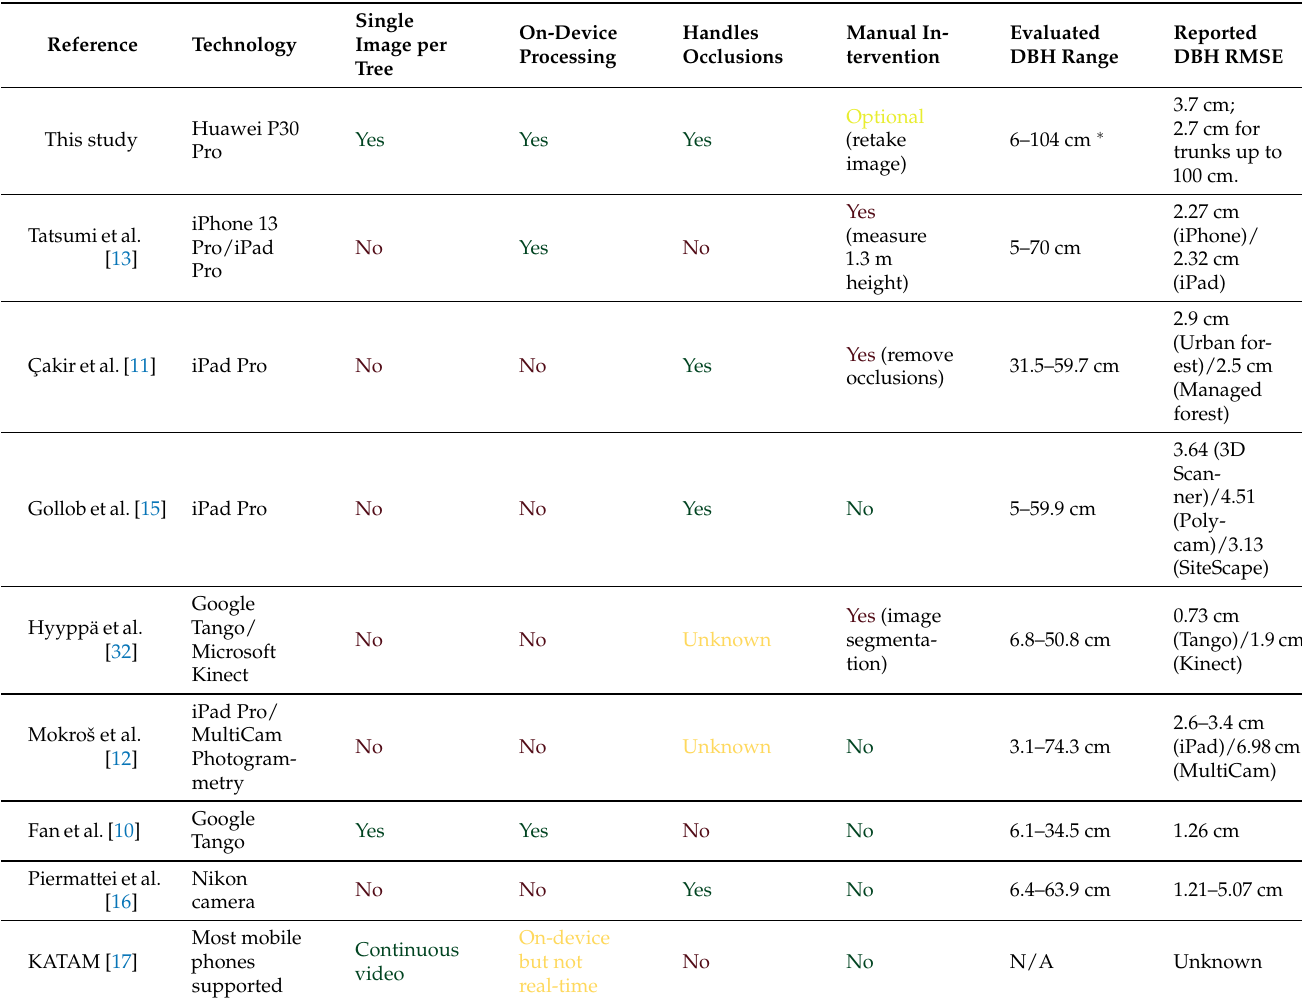
Table A1. Comparison with prior